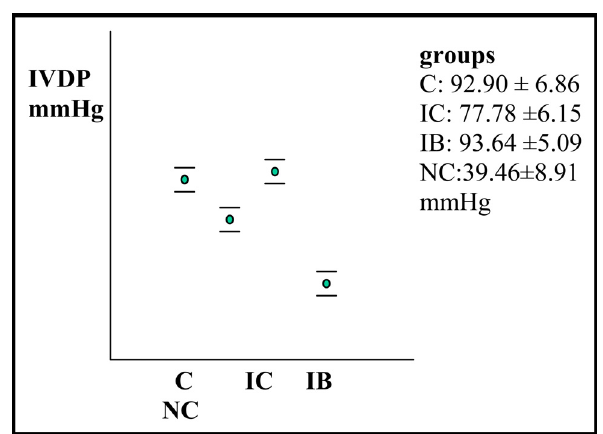
FIGURE 1 - Graphic representation of IVDP (Intraventricular Developed Pressure) and groupsC-control; IC- ischemic crcrystalloid; IB-ischemic Blood; NC- ischemic non